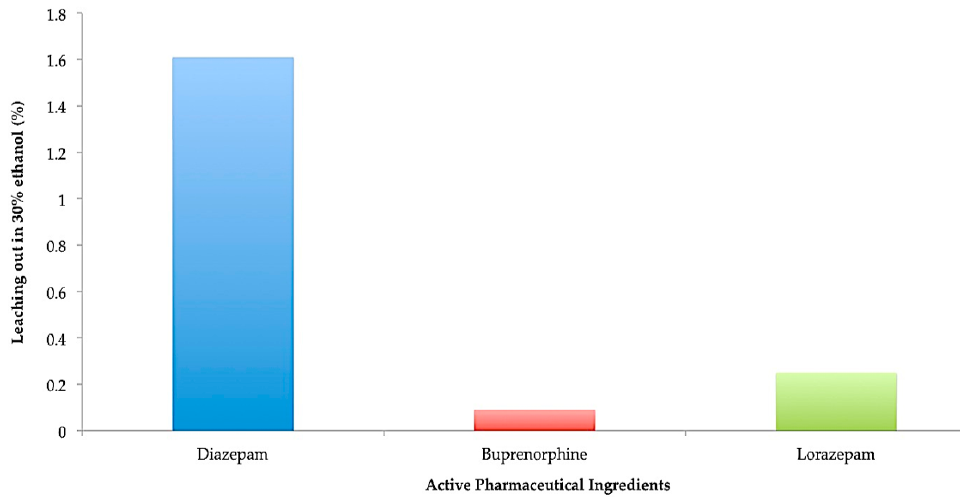
Figure 11. Desorption study in 30%